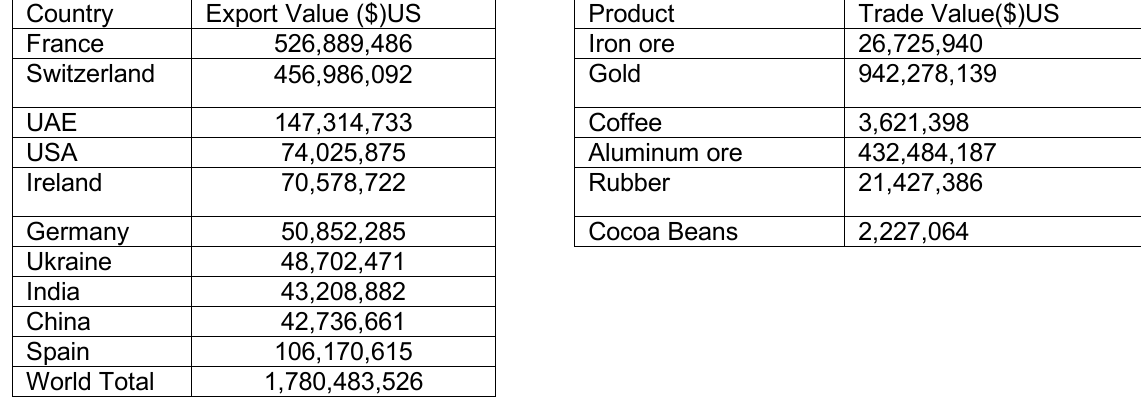
Table 1a: Export trading partners and products of Guinea (UN Comtrade database, 2013) Guinea top export products and exporting partners in 2013